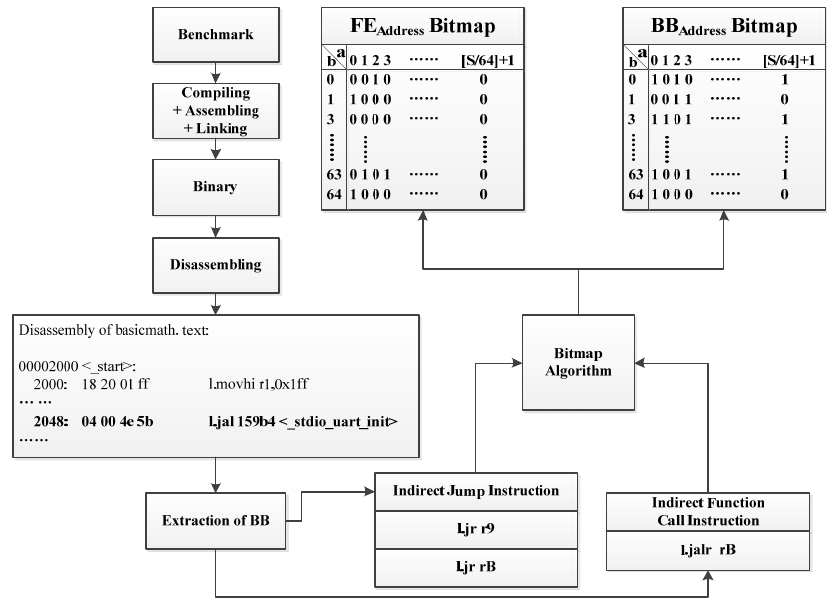
Figure 5. Extracting the bitmap of the legal jump target address.